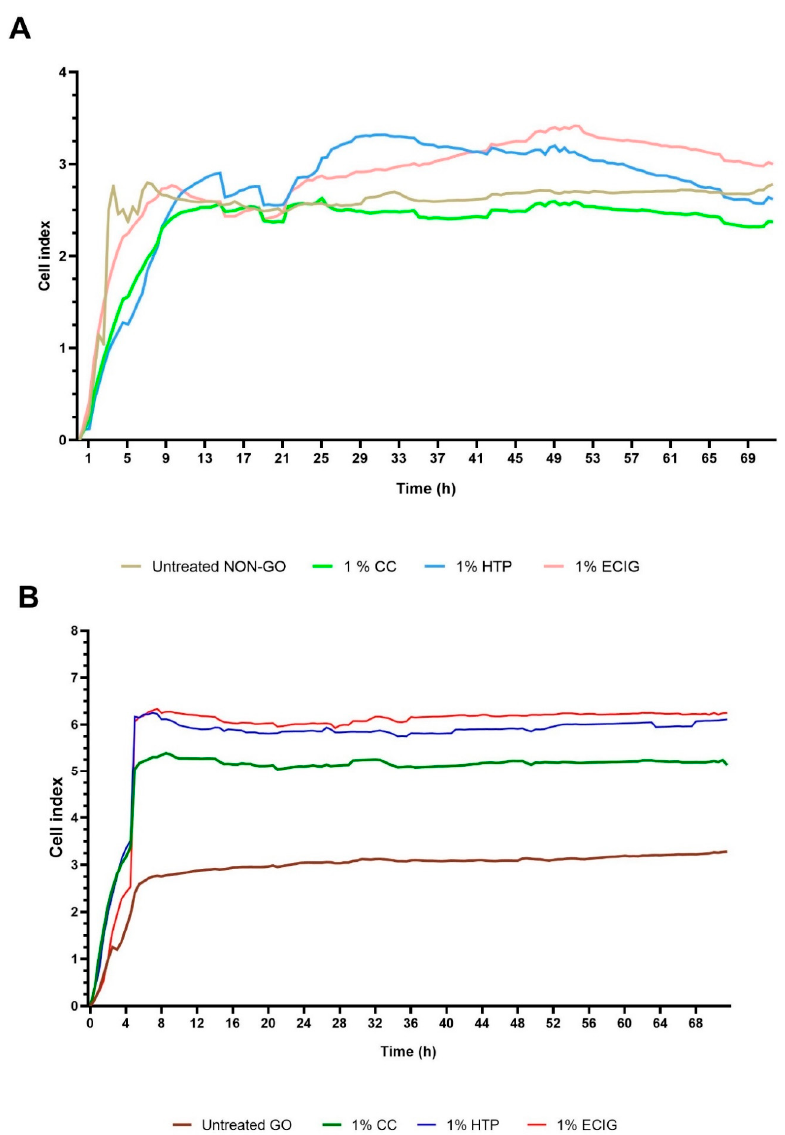
Figure 6. The effect of 1% CC, HTP and ECIG on the cell index of NON-GO OF ( A ) and GO OF ( B ). All experiments were performed in triplicates. All tobacco product treatments caused significant elevation in cell index in GO OFs, while NON-GO OFs were less affected by either treatment.